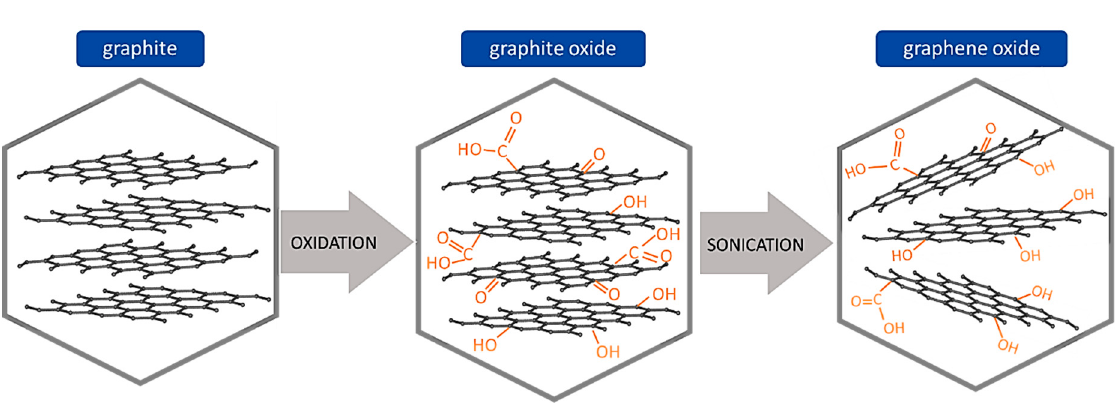
Figure 8. Representation of the general graphene oxide synthesis.